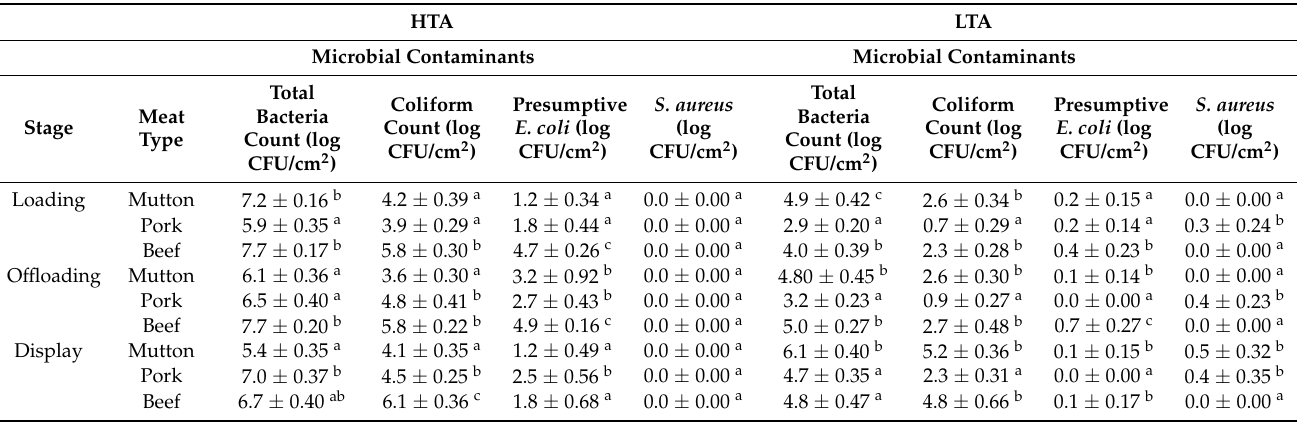
Table 1. Least square mean values ( ± SE) for microbial counts per meat type at different stages of the distribution chain in each